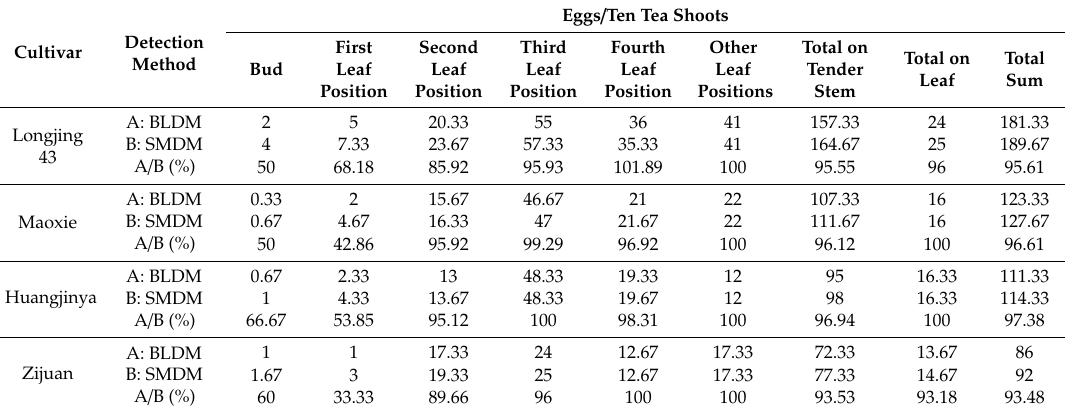
Table 3. Comparison between the BLDM and the SMDM for the egg detection of E. onukii.